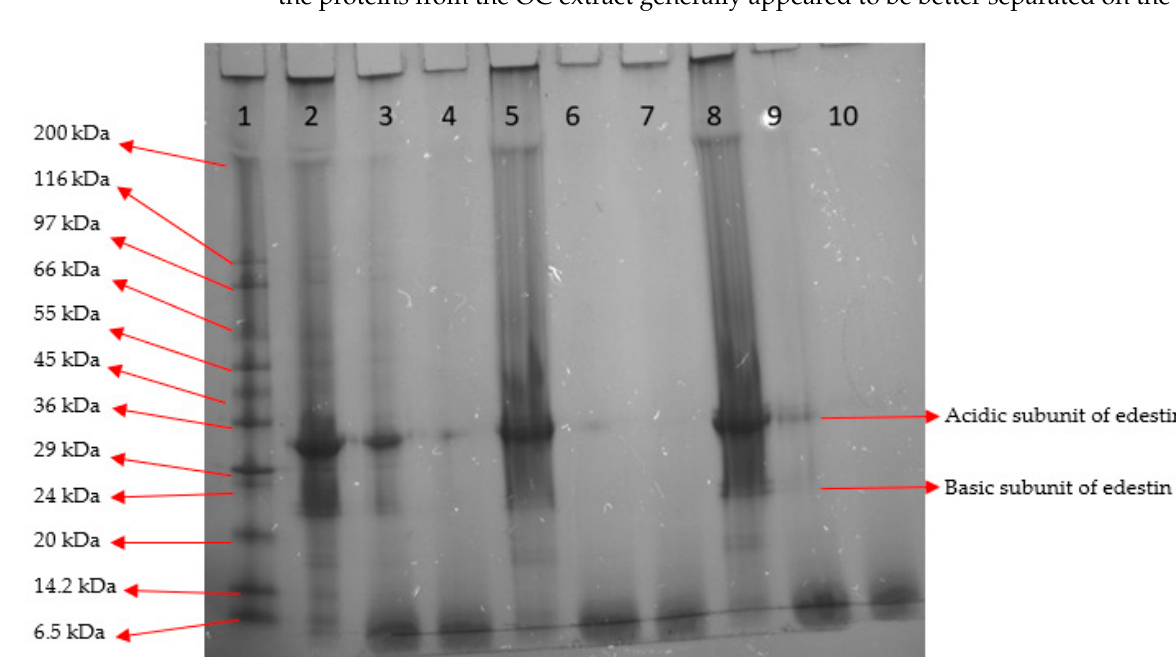
Figure 4. Sodium dodecyl sulfate polyacrylamide gel electrophoresis (SDS-PAGE) profile of 1, molecular mass marker; 2, 5, 8, intact; 3, 6, 9, gastric digested; and 4, 7 and 10, gastrointestinal digested protein samples from an organically (OC) and two conventionally (CC1 and CC2) cultivated hempseeds, respectively.